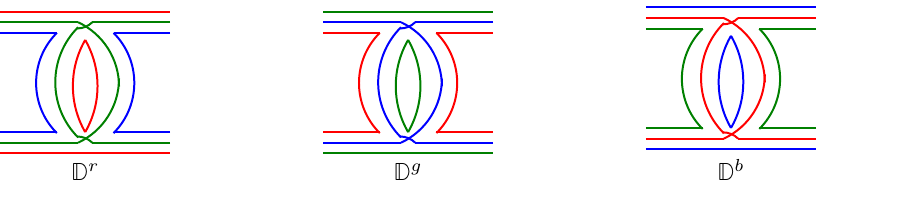
Figure 11. Dipoles of three colors in KT Model.